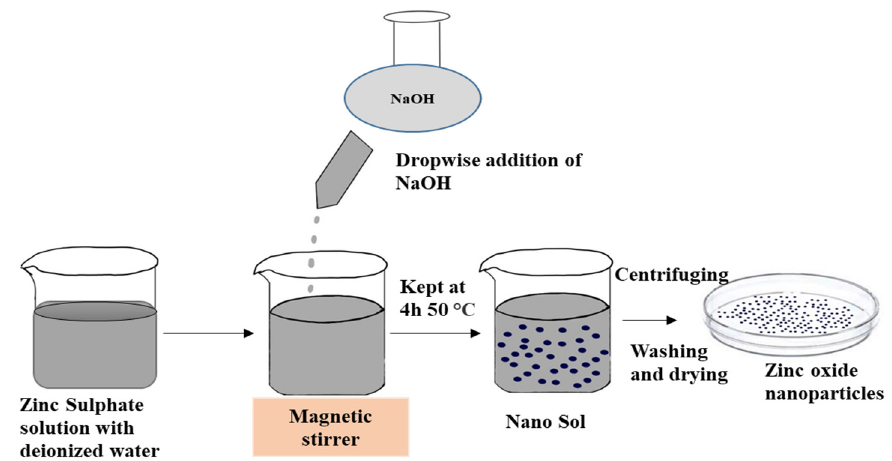
Figure 1. Experimental setup for the synthesis of ZnO